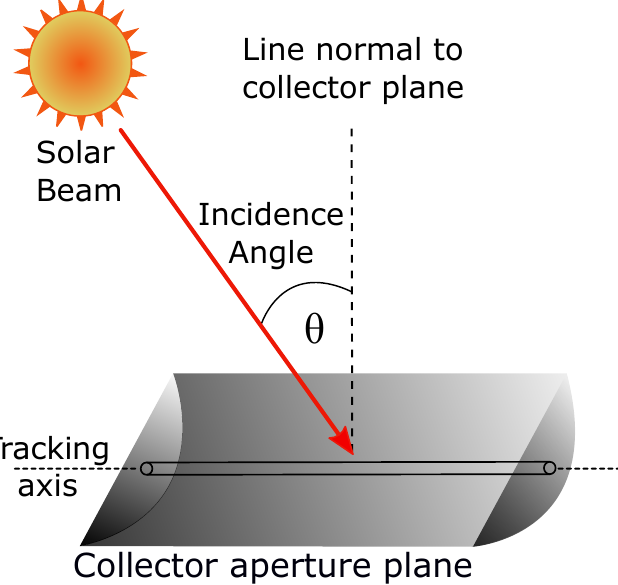
Figure 8. Schematic of a